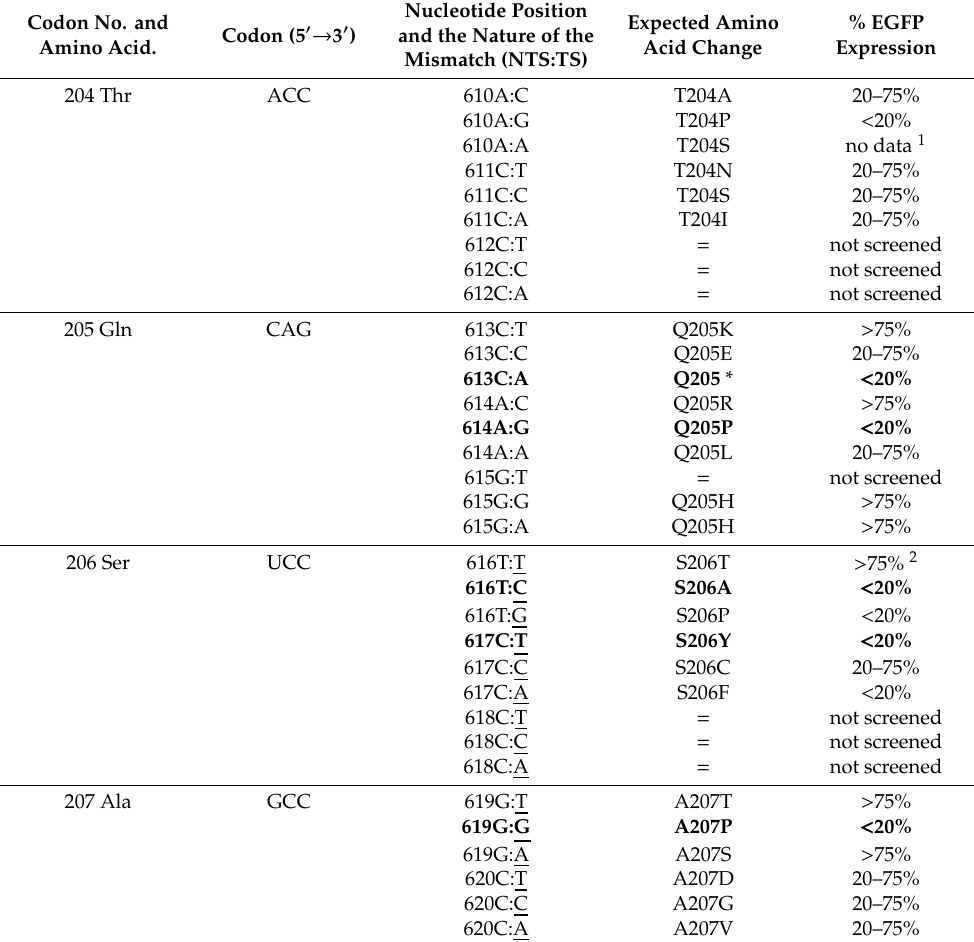
Table 1. Analysis of the EGFP coding sequence fragment flanked by the available Bpu10I sites and the results of preliminary screening based on the expression of mismatch-containing constructs in DLD1 cells. Candidates selected for validation and the Q205* mutation characterized previously are highlighted in bold